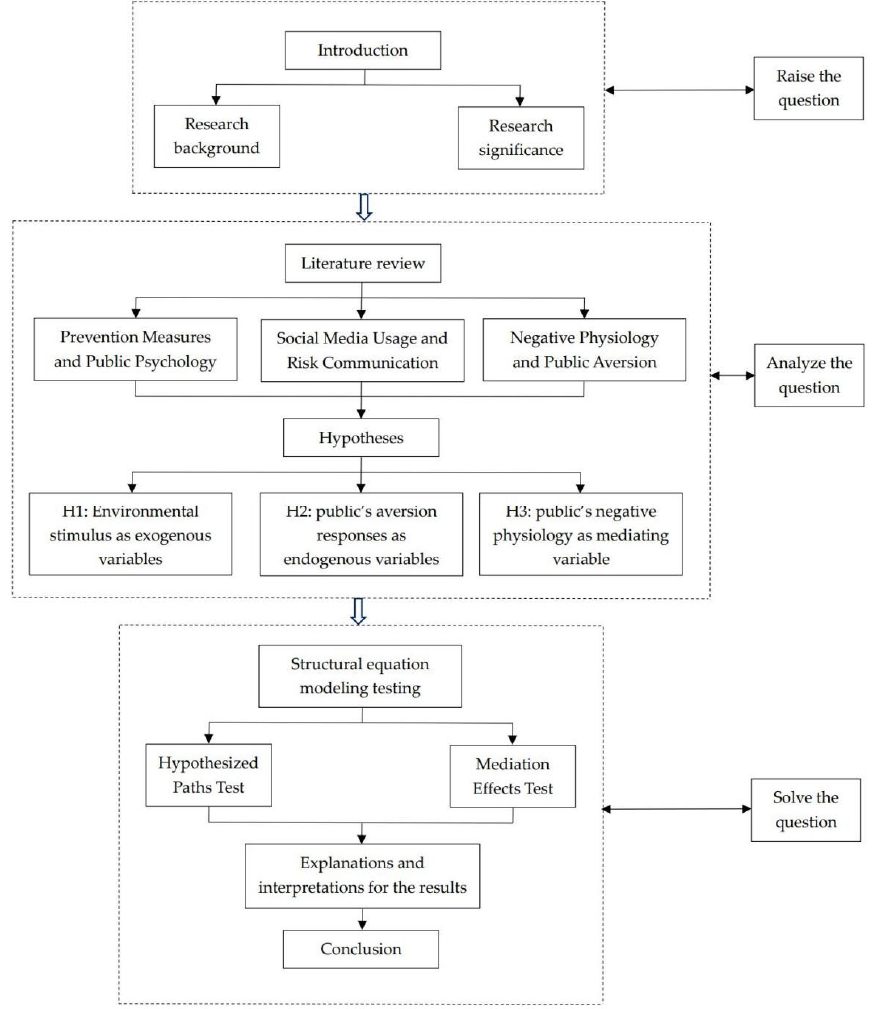
Figure 2. Steps of the research project.